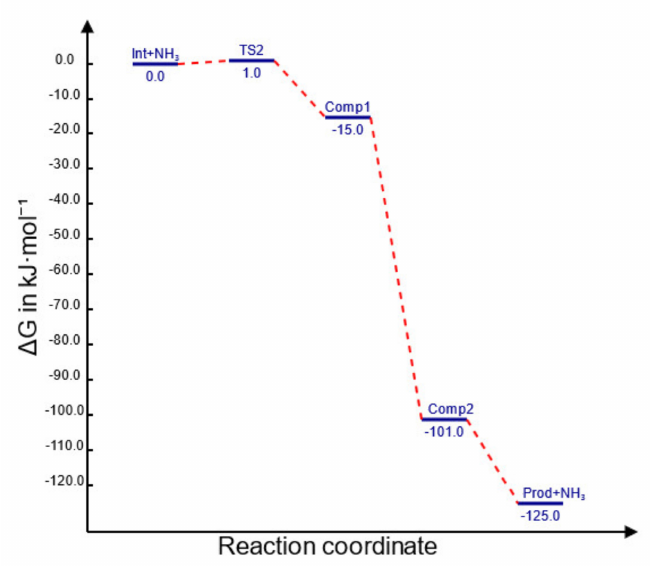
Figure 3. Energy profile of isomerisation of [B 12 H 11 NCCH 3 NH 3 ] − (Int) to [B 12 H 11 NHCCH 3 NH 2 ] − (Prod) in water